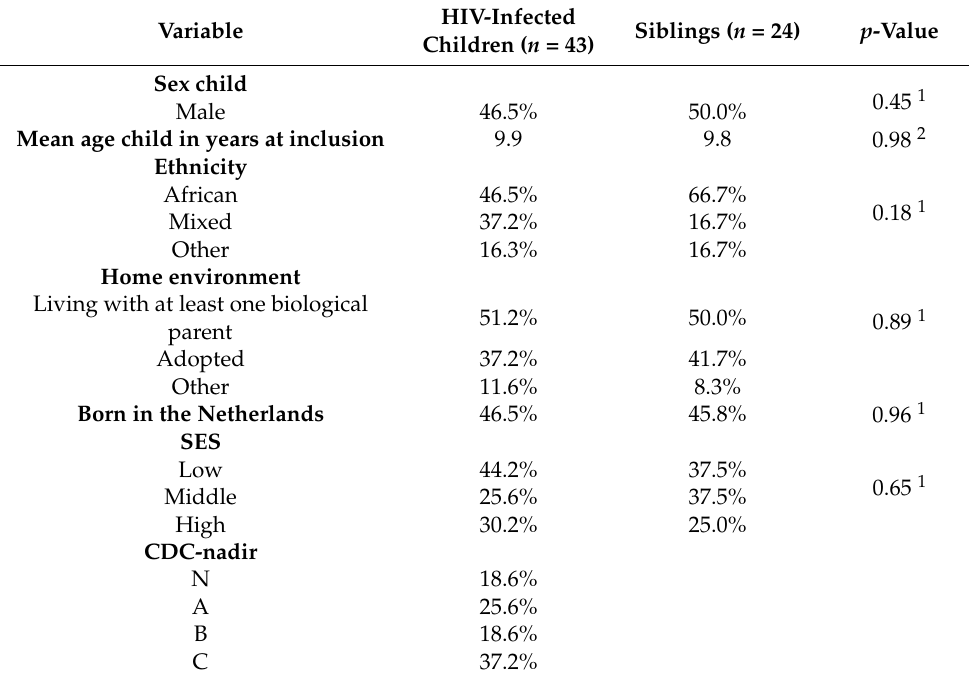
Table 1. Socio-demographic and medical characteristics of patients and